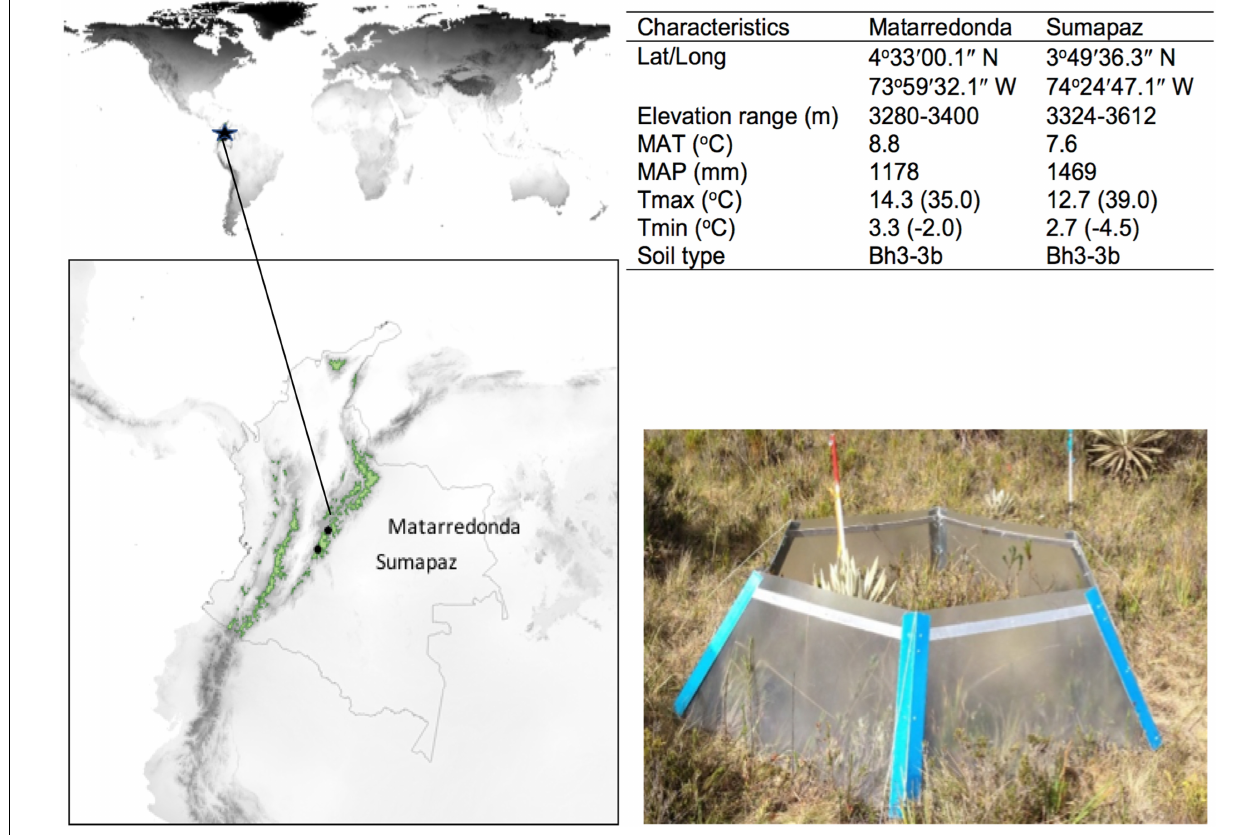
Frontiers in Ecology and Evolution |